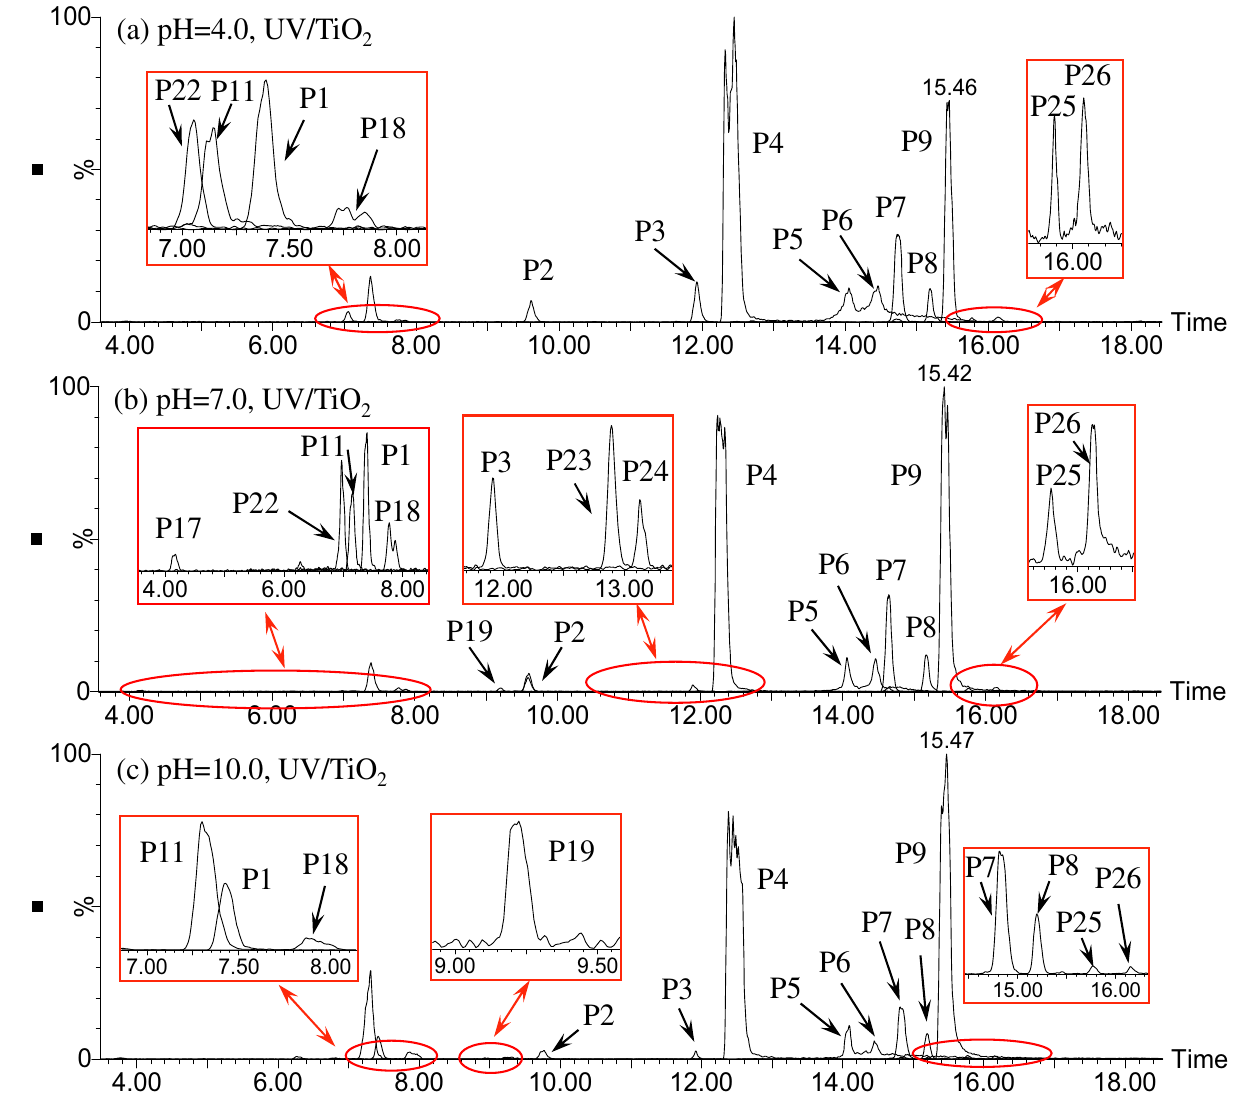
Figure 6. The extracted ion chromatograms (EICs) of ATZ solution after 90 min irradiation in UV/TiO 2 process: ( a ) pH = 4.0; ( b ) pH = 7.0; (c) pH =